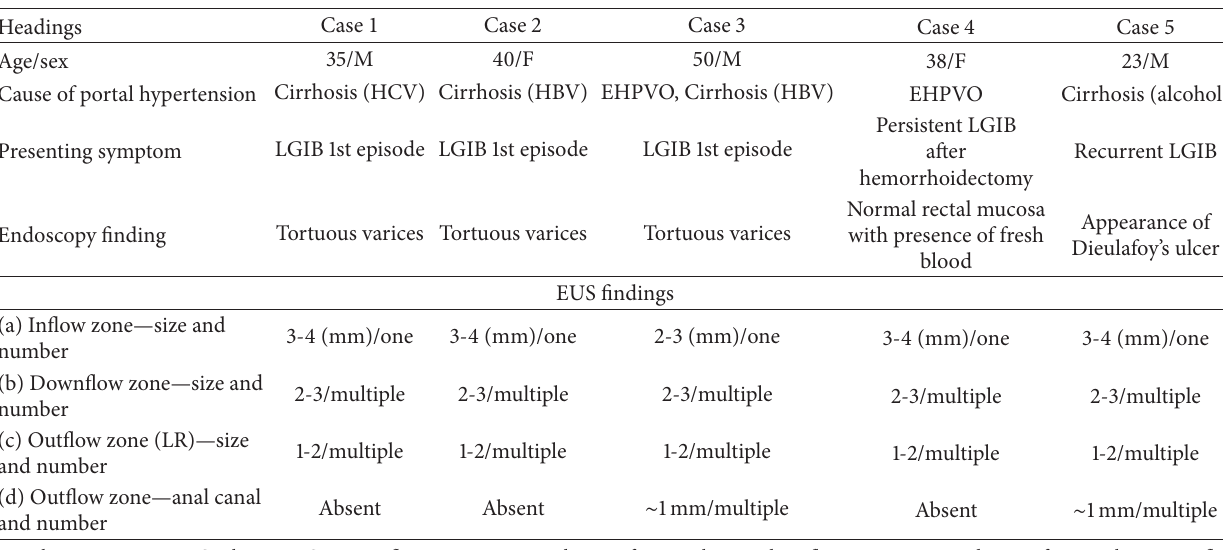
Table 1: Baseline characteristics and endoscopic and EUS